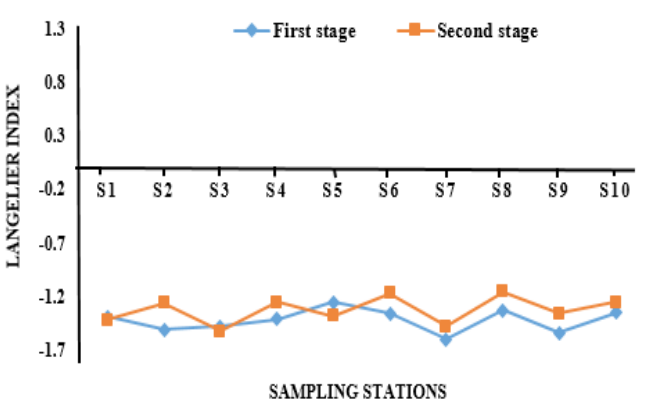
Figure 1. Comparison of LSI values for Meshginshahr’s drinking water distribution system